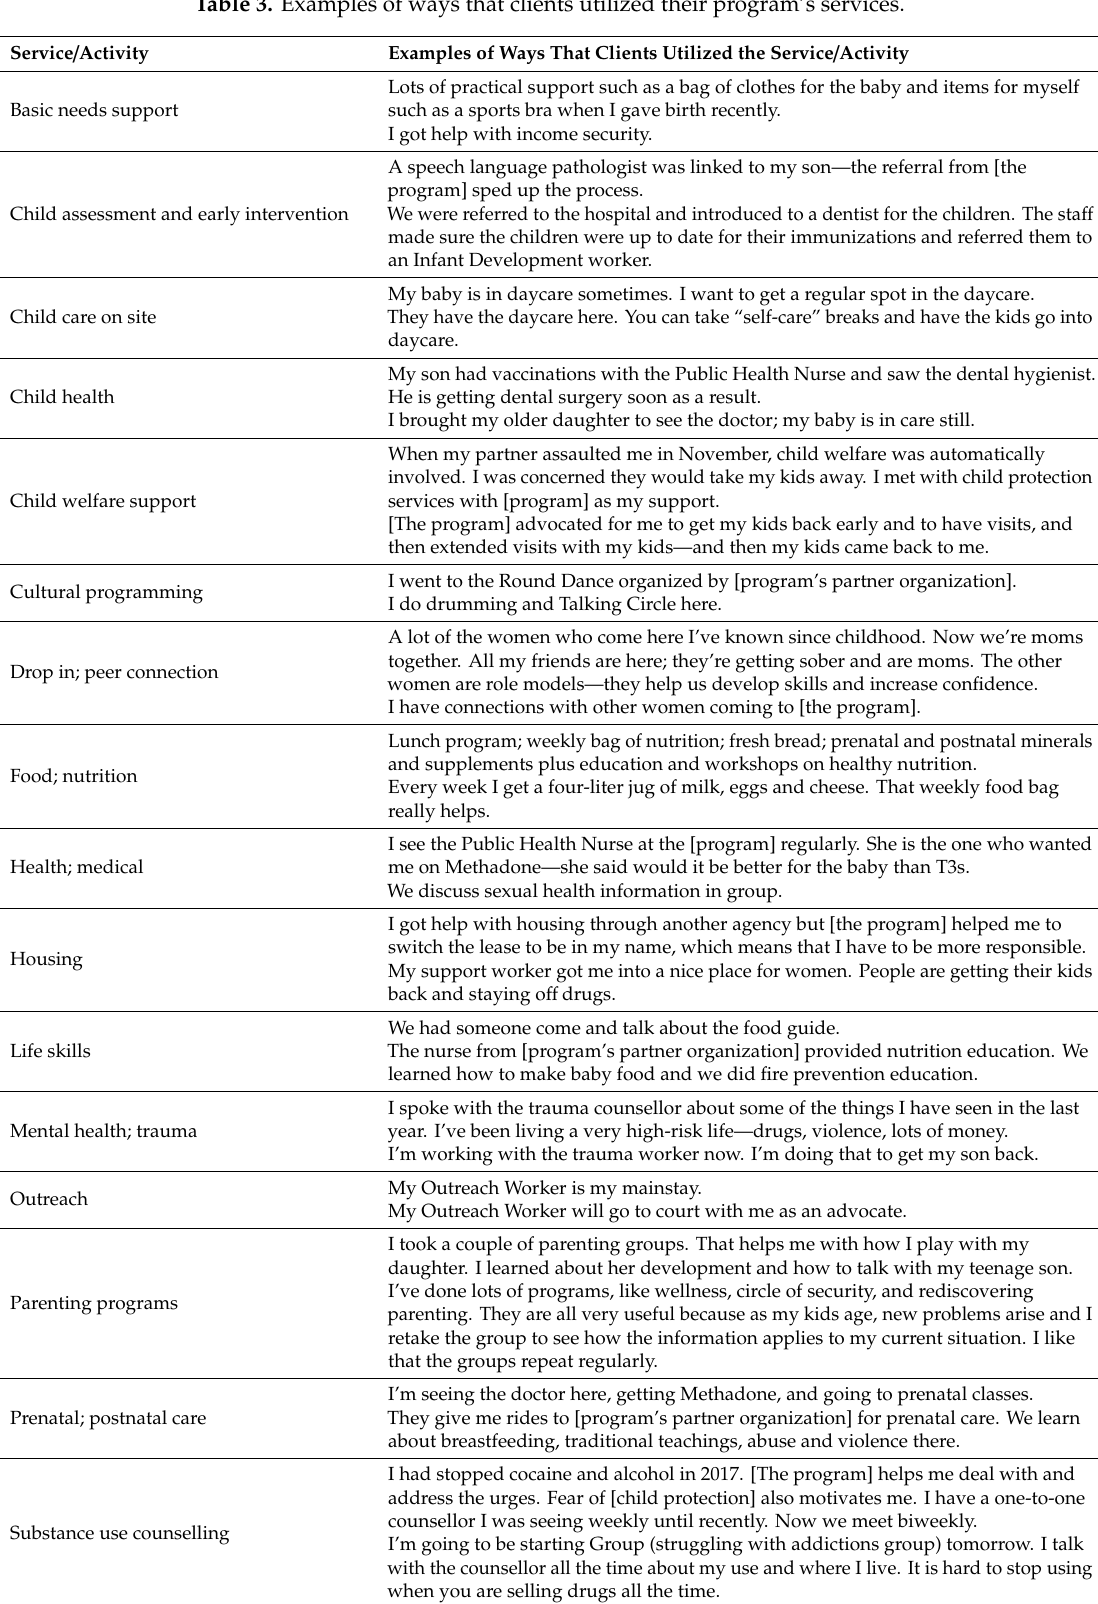
Table 3. Examples of ways that clients utilized their program’s